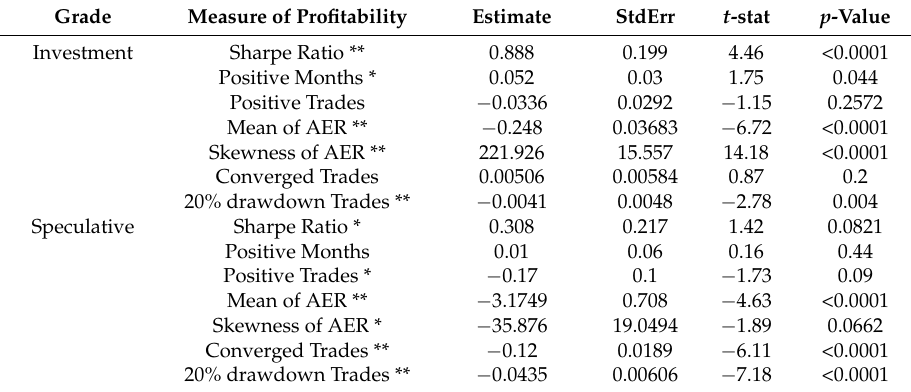
Table 4. TS2 vs. TS1.